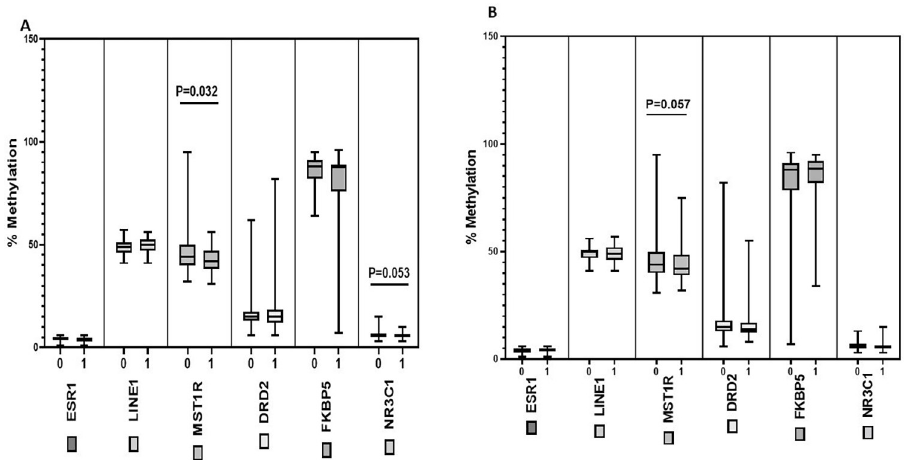
Fig 3. Quantitative DNA methylation analysis and correlation with self-reported exposure to violence and stress. The percentage of DNA methylation levels at promoter CpG island were compared with exposure to violence (A) and stress level (B). Y axis, percentage of methylated cytosines in the samples as obtained from pyrosequencing. X axis, exposure to violence (0 = no exposure; 1 = exposure to violence) or stress (0 = no stress, 1 = stress). P value is indicated for genes that shows significance and nominal significance (p < 0.05; Mann-Whitney